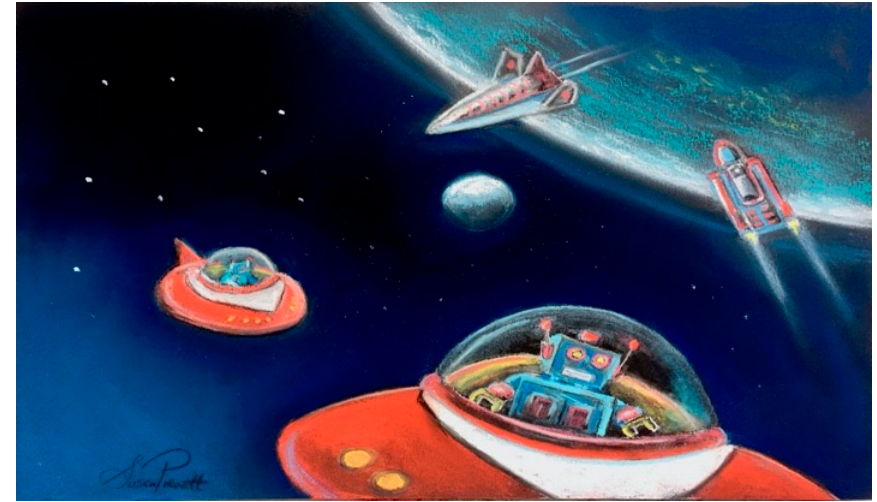
Figure 8. Technology “Sci-fi” Utopian Themes. These themes have a technocratic focus on advanced science and technology, resources for material abundance and a perceived trajectory away from societal warmth. Driven by “experts”, there is little perceived role for “ordinary” people, and little motivation for social change (even when perceived positively). Artwork by S.L.P.